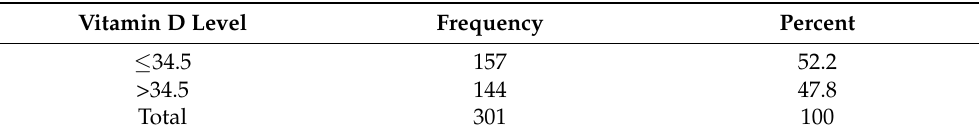
Table 5. Vitamin D Status among the Study Groups.